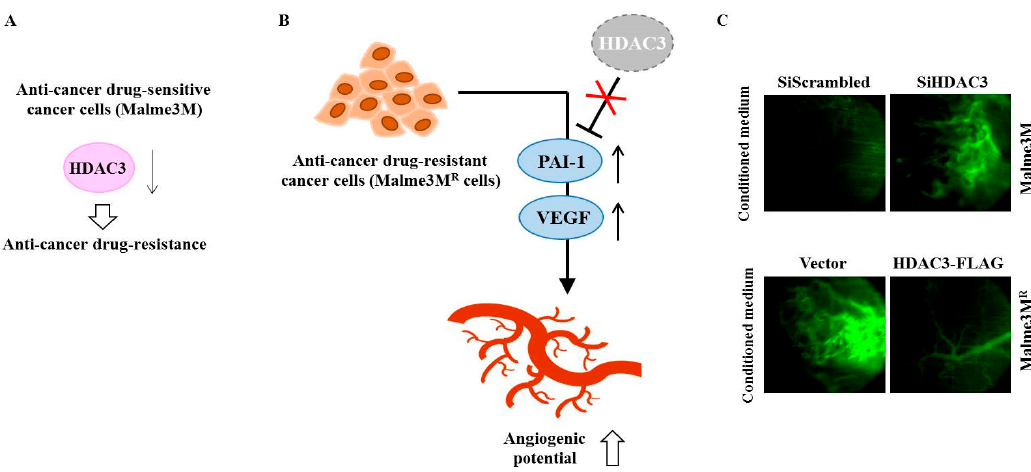
Figure 3. HDAC3 regulates the angiogenic potential of cancer cells. ( A ) In anti-cancer drug-sensitive cancer cells (Malme3M cells), the down-regulation of HDAC3 confers resistance to anti-cancer drugs. ( B ) In anti-cancer drug-resistant cancer cells (Malme3M R cells), decreased expression of HDAC3 leads to increased expression levels of angiogenic factors, such as PAI-1 and VEGF. ( C ) Malme3M cells or Malme3M R cells were transfected with indicated siRNA or construct. Conditioned medium obtained after transfection was mixed with matrigel and subjected to intravital microscopy. The ↑ arrows denotes increased expression level and ↓ arrows denotes decreased expression level.